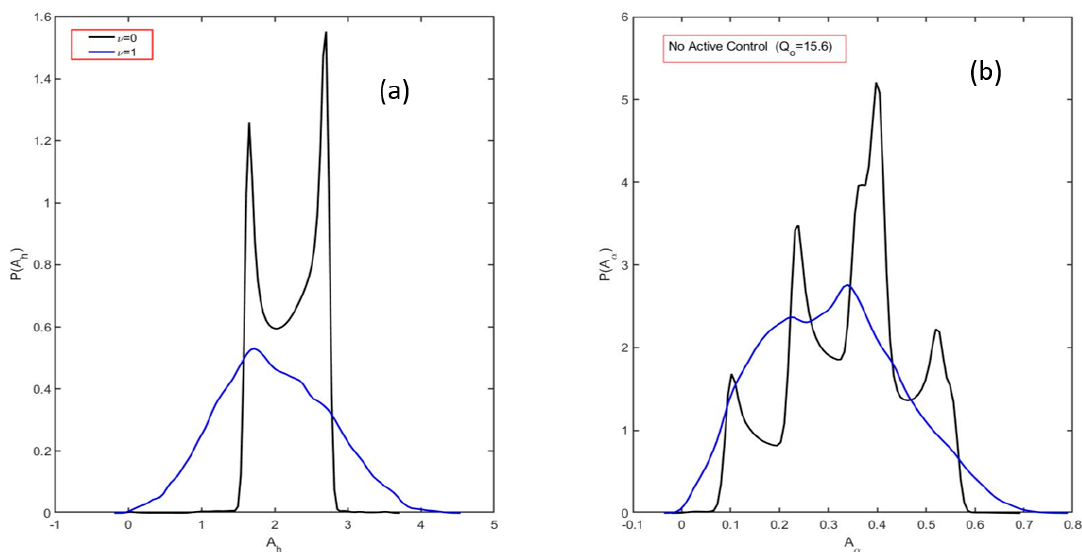
Figure 28. Probability density functions for aeroelastic displacements (open-loop, ν = 1 ). ( a ) Comparison of bending (h) pdfs (un-forced & with random excitation). ( b ) Comparison of pitch ( 𝛼 ) pdfs (un-forced & with random excitation). The noise intensity suppresses phase coherence